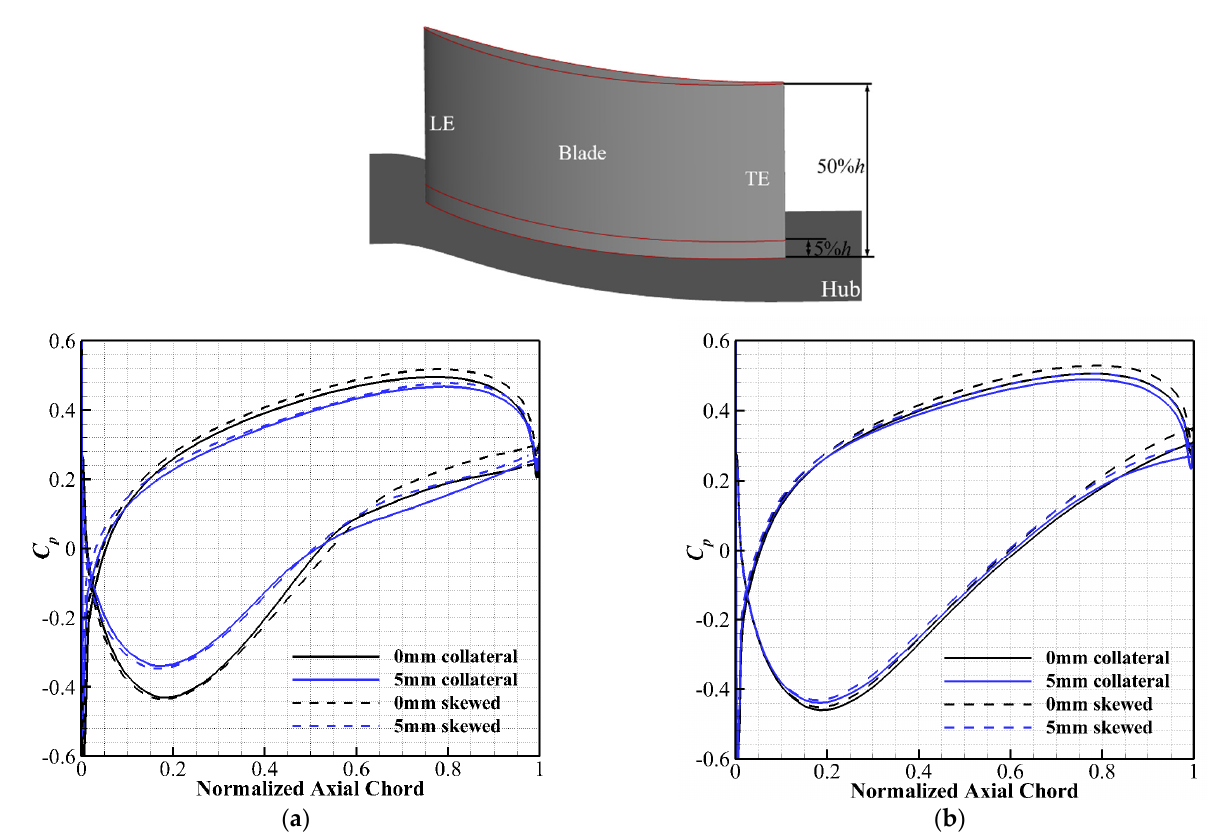
Figure 10. The C p distributions of the blade surface along the normalized axial chord of the original cascade at 5% h and 50% h : ( a ) 5% h ; ( b ) 50% h .